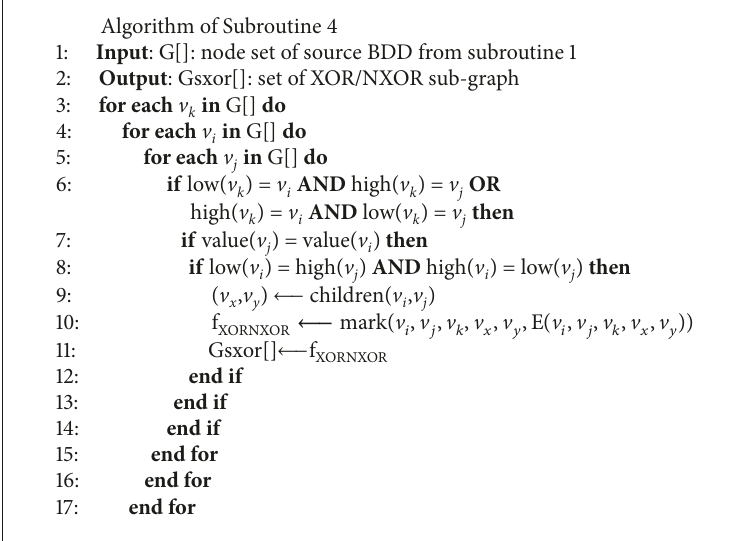
Algorithm of Subroutine 4